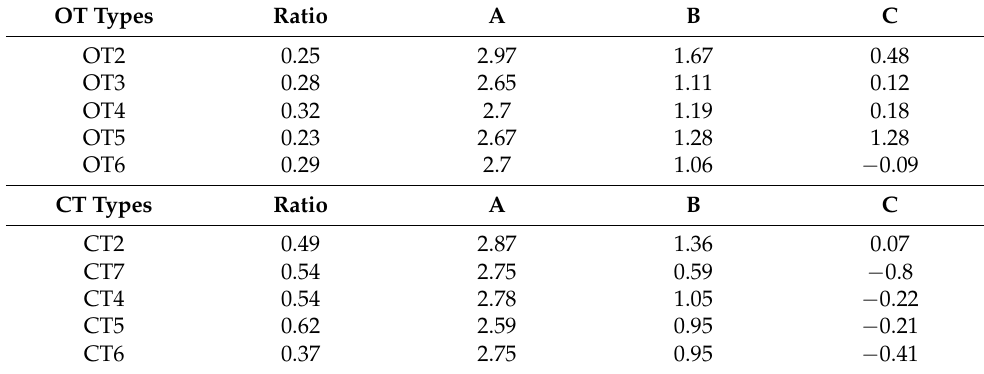
Figure 13. PMV indices and built-up ratio. Figure 13. Average wind speed and built-up ratio on 17th, 24th January, and 19th February at 2 pm. Table 20. Summary of PMV Table 20. Summary of average wind speed value on 17th (A), 24th January (B), and 19th February (C) at 2 pm and built-up ratio in Open and compact type arrangements.